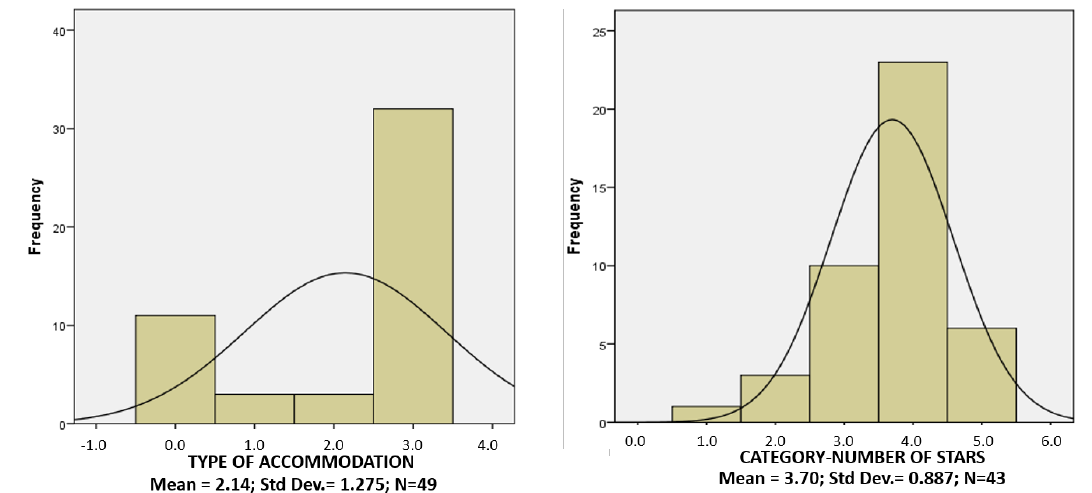
Figure 3. Types and categories of accommodation in Agadir.